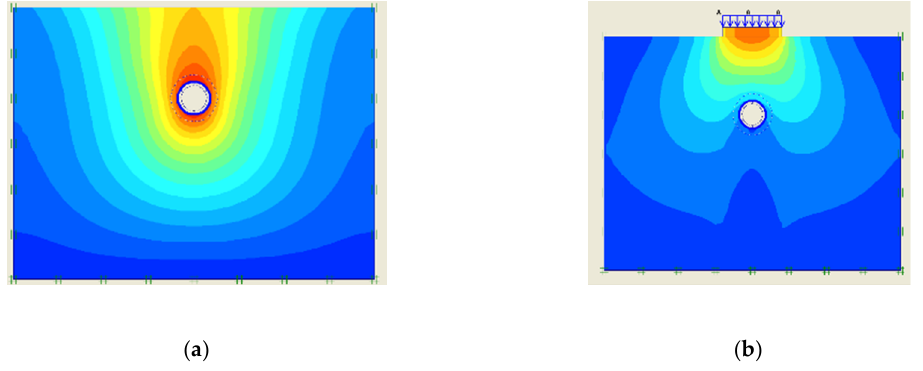
Figure 14. The total displacements shading, ( a ) without foundation and ( b ) with foundation.